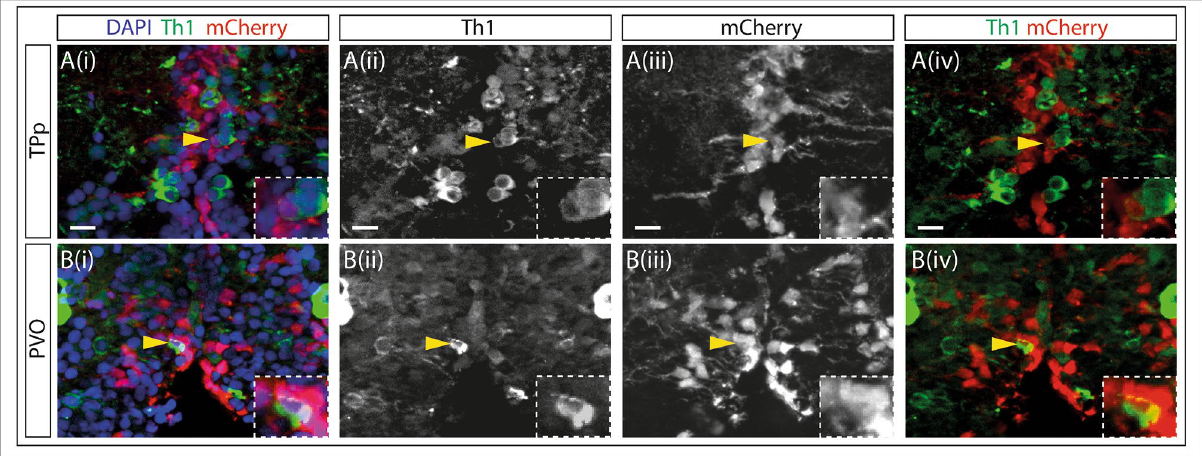
Figure 4. DA neurons in the adult PVO are generated from Her4-expressing progenitors. ( A–B ) Fluorescent MIP of the PT of double transgenic (Tg(her4:ERT2CreERT2); Tg(ubi:loxGFPloxmCherry)) 3 month zebrafish injected with tamoxifen. Cell nuclei are labelled with DAPI (blue), DA neurons with Th1 (green) and Her4 progenitors with mCherry (red) throughout. Th1 is shown as a single channel in (ii), mCherry is shown in (iii). Th1 (green) and mCherry (red) are shown together in (iv). Boxed regions show magnified image of the double labelled cell. ( Ai–iv ) TPp: mCherry and Th1 mark adjacent cells but are not co-localised (yellow arrows). ( Bi– iv ) PVO: Double staining shows co-localisation of mCherry and Th1. The presence of mCherry + Th1 + cells in the PVO suggests that newly generated DA neurons are derived from Her4 progenitors in this neuronal subpopulation. Yellow dashed line indicates